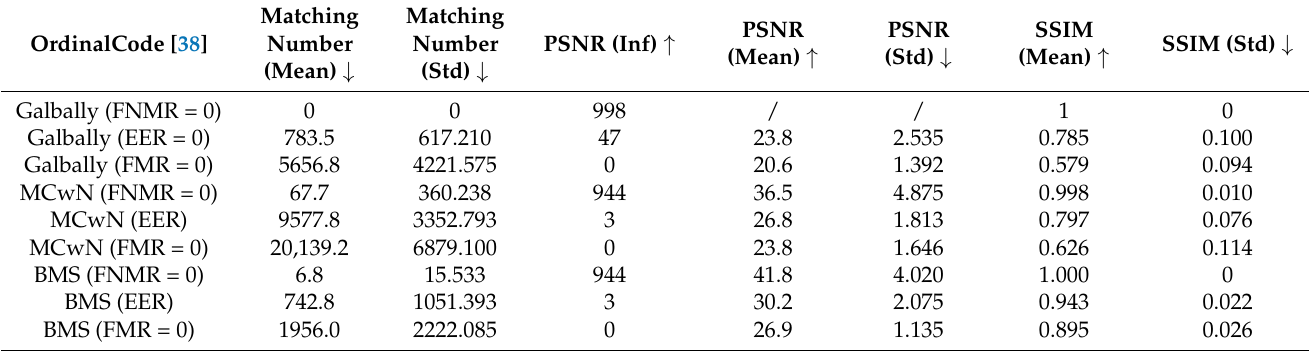
Table 5. Attack performance of OrdinalCode